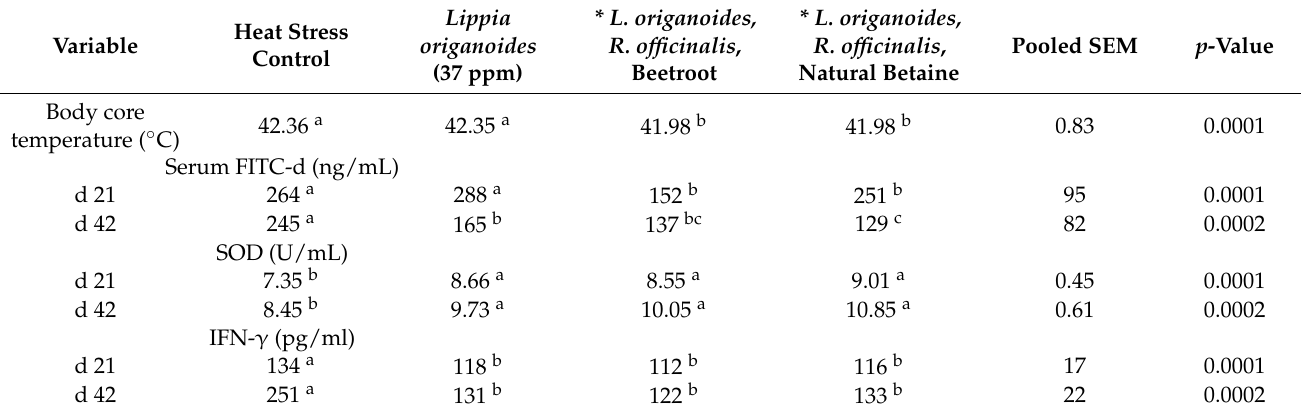
Indicates significant differences between the treatments within the rows ( p < 0.05). Table 3. Evaluation of essential oils on broiler chickens exposed to cyclic heat stress on body core temperature, serum biomarkers for intestinal inflammation, and bone parameters at days 21 and